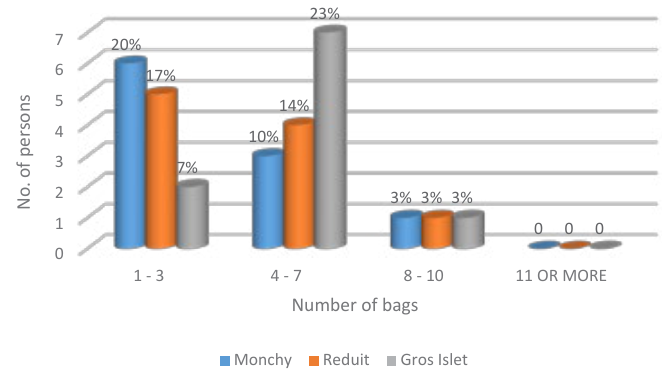
Fig. 3: Weekly municipal waste generation by community